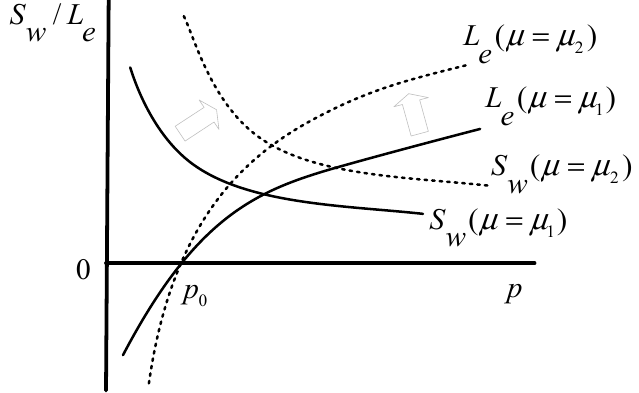
μ on the investors’ profits and social welfare (